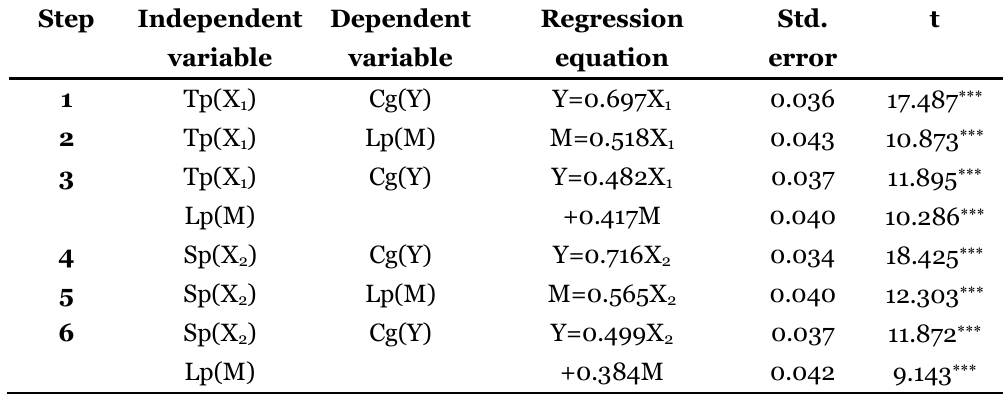
Mediating Effects of Learning